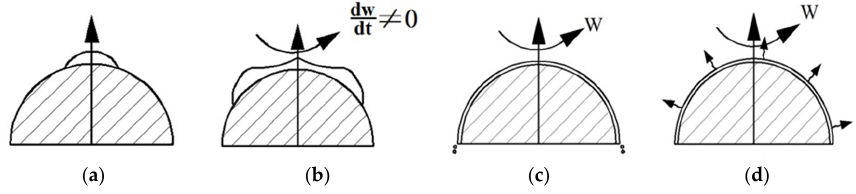
Figure 1. Schematic of four stages of spin coating process: ( a ) deposition, ( b ) spin up, ( c ) spin off, and ( d ) evaporation.